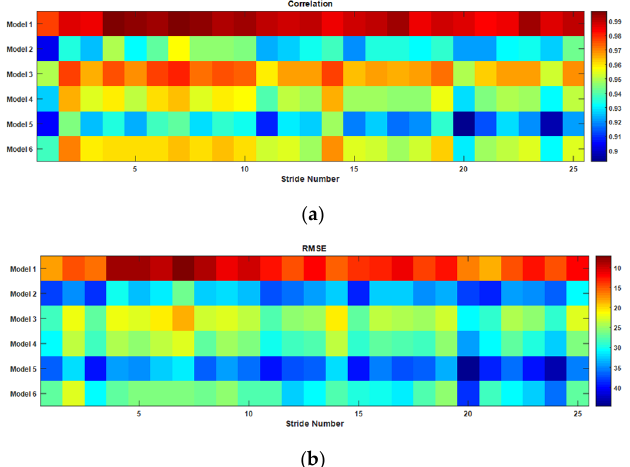
Figure 18. The correlation ( a ) and RMSE ( b ) of the gyro signal of each stride to the model-generated waveform for slow walking.